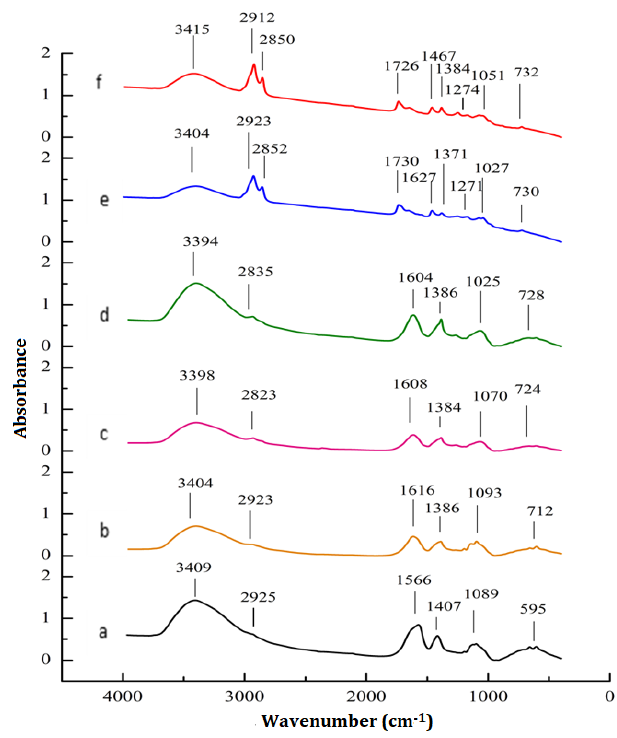
Figure 1. FTIR spectra of S. arvensis leaf extracts with six different extracting solvents, (a) water, (b) 10%